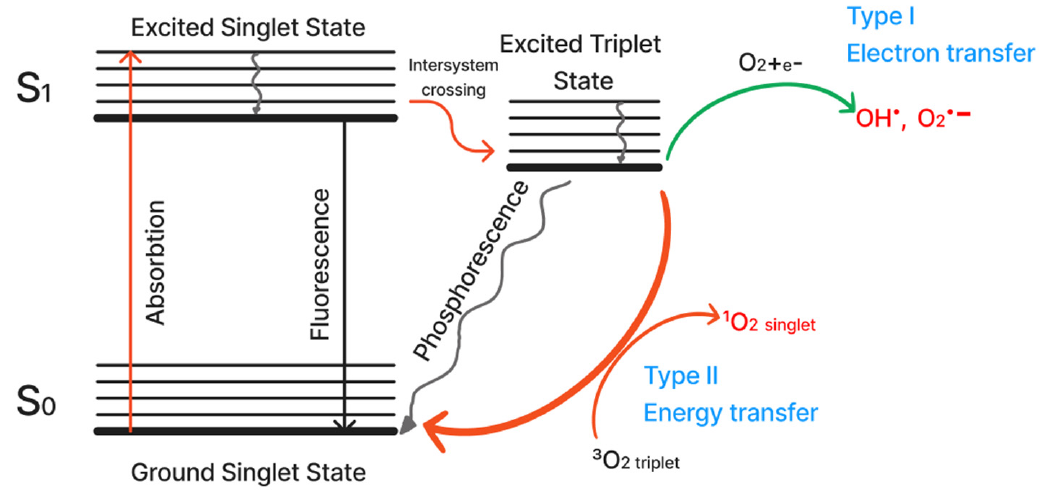
Figure 1. Singlet oxygen generation mechanism (Jablonski diagram) [9,11,16]. The main types of chromophores of such compounds are shown in Figure 2; these are porphyrins and phthalocyanines (usually as metal complexes) [10,23], hypericin [7], pery- lene compounds [6,7], compound LJ001 and congeners [20], and methylene blue [24]. They are lipophilic aromatic compounds, capable of penetrating into the lipid bilayer. Obvious prerequisites for a pronounced antiviral effect are (1) localization of the chromophore in close proximity to the double bonds of unsaturated fatty acids in the lipid membrane; (2) the presence of oxygen; and (3) light exposure in the area of chromophore absorption. The latter condition is easily met in the case of viral skin infection and can be implemented for the upper respiratory tract [25], which makes many classes of photosensitizers potentially applicable to the therapy of such infections. However, in the case of the internal localization of viral replication foci, light delivery is difficult.